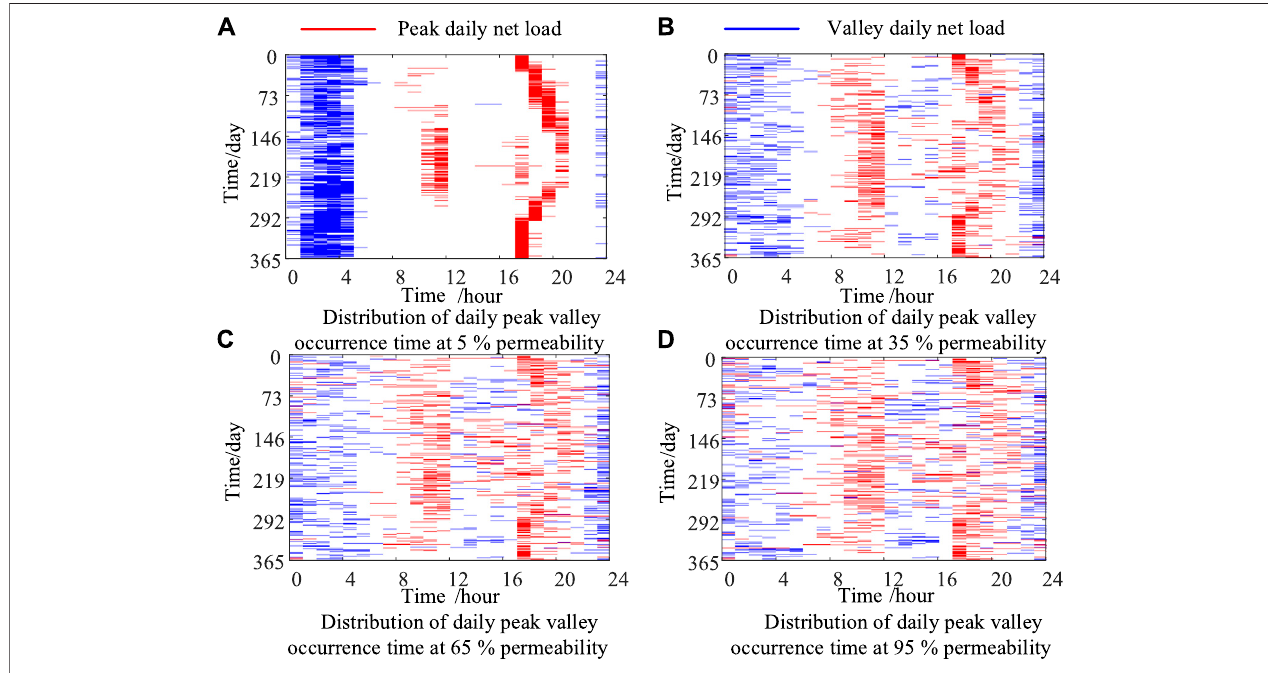
FIGURE 2 | Distribution of peak and valley occurrence